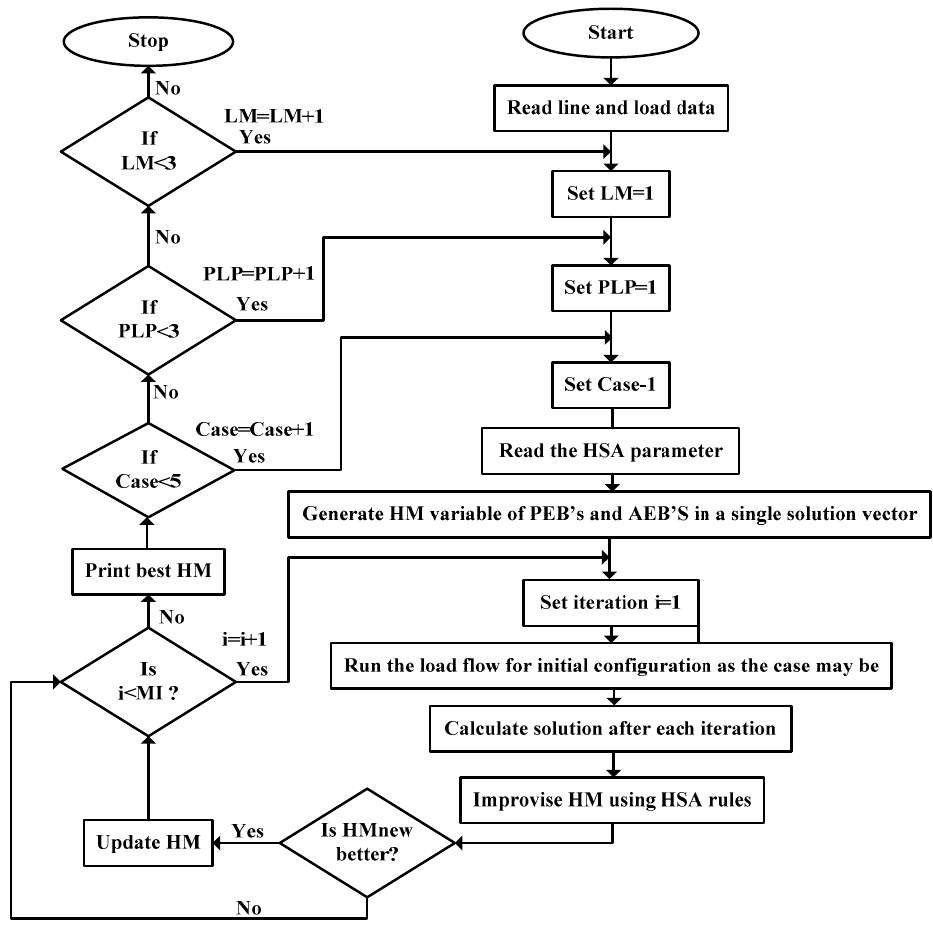
Figure 2. Flowchart of the proposed algorithm.